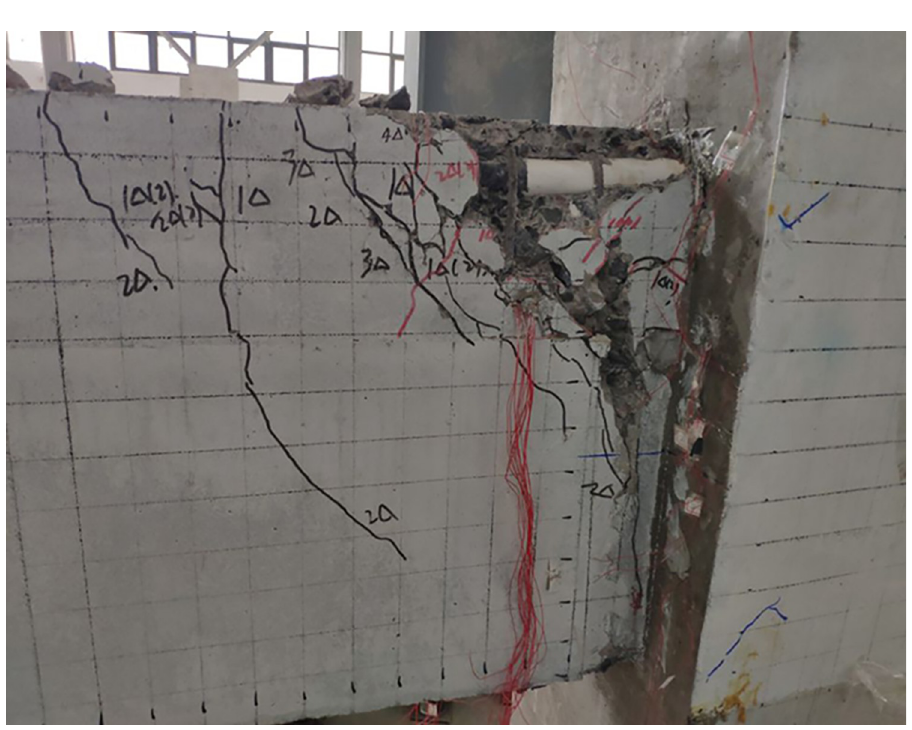
Fig 12. Failure mode of